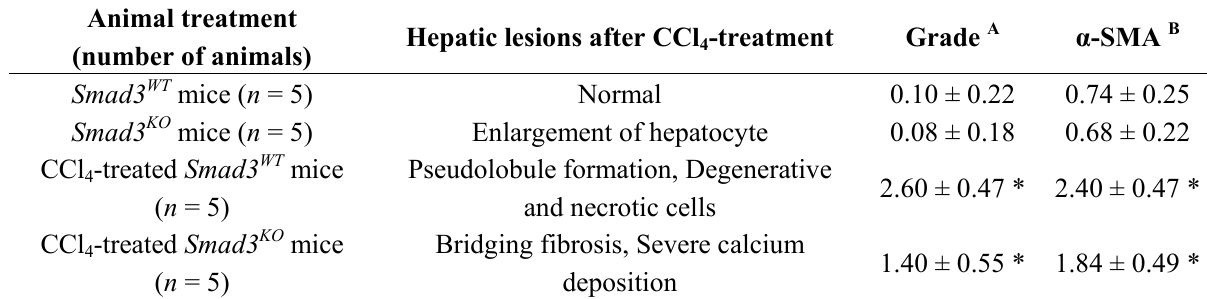
Table 1. Hepatic lesions and grade of fibrosis in the livers of Smad3 -mutant mice after the CCl 4